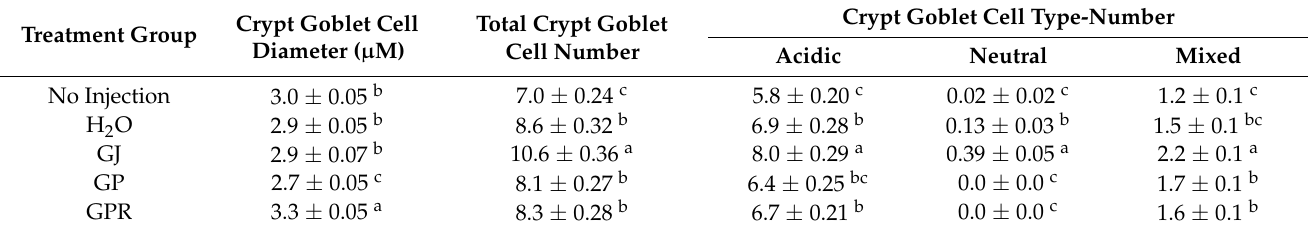
Table 6. Effect of the intra-amniotic administration of grape juice (GJ), pomace (GP), and puree (GPR) on the duodenal crypt goblet cell type, number, and diameter.